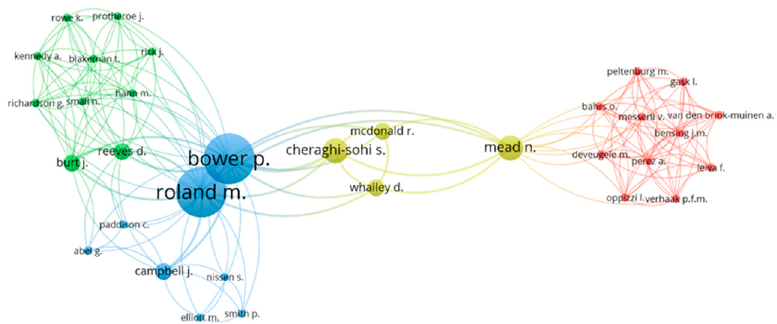
Figure 6. Network of cooperation based on co-authorship of the prominent